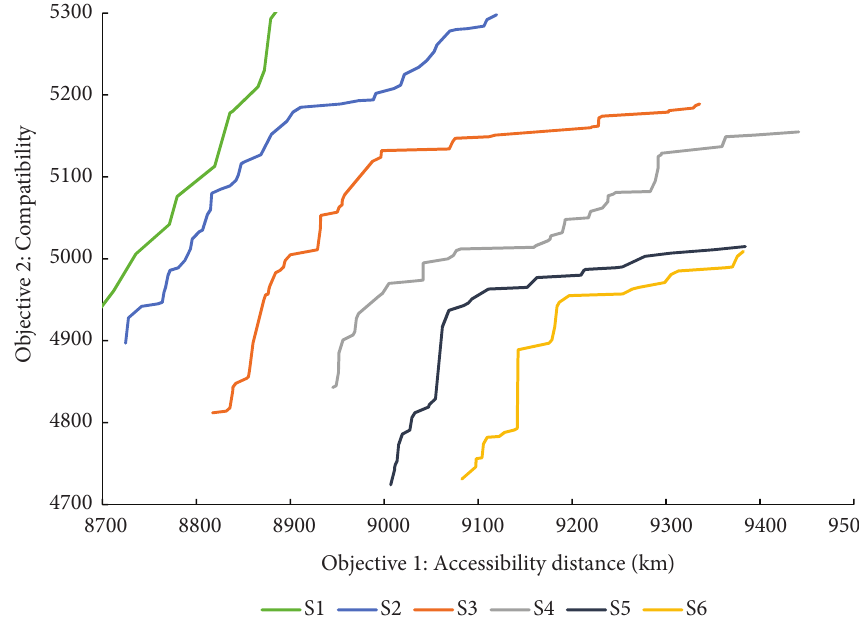
Figure 7. Pareto fronts for the six runs in the sensitivity investigation